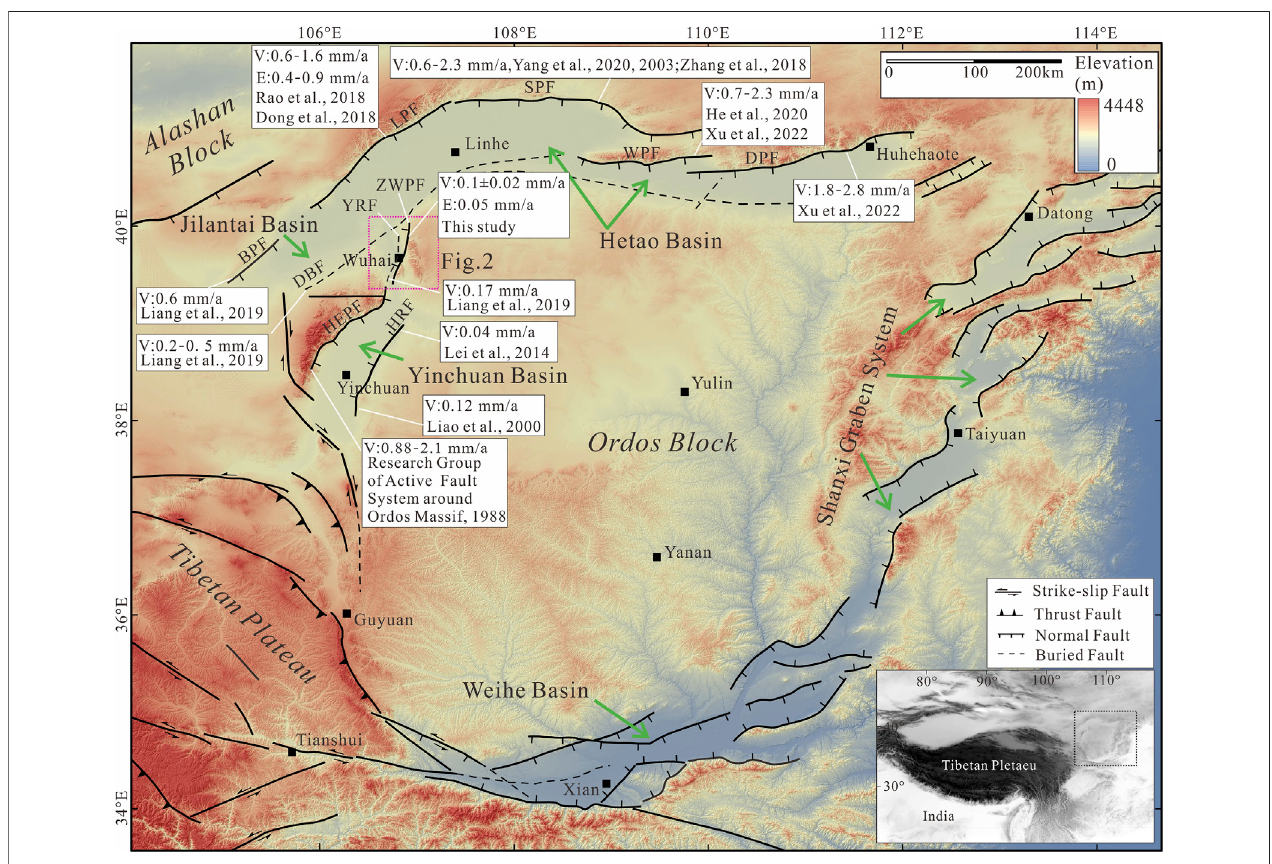
FIGURE1| TopographicmapoftheOrdosBlockshowingmajoractivefaultsandthelocationofthestudyarea.Activefaultsaremodi fi edfromDeng(2007)andour ownobservations.Thepinkdashedrectangleshowsthelocationof Figure2 .Abbreviationsofnamesofactivefaults:DPF,DaqingshanPiedmontFault;WPF,Wulashan Piedmont Fault; SPF, Seertengshan Piedmont Fault; LPF, Langshan Piedmont Fault; BPF, Bayanwulashan Piedmont Fault; DBF, Dengkou-Beijing Fault; YRF, Yellow River Fault; ZWPF, Zhuozishan West Piedmont Fault; HEPF, Helanshan East Piedmont Fault; HRF, Huanghe River Fault. V: vertical slip rate. E: extension rate.